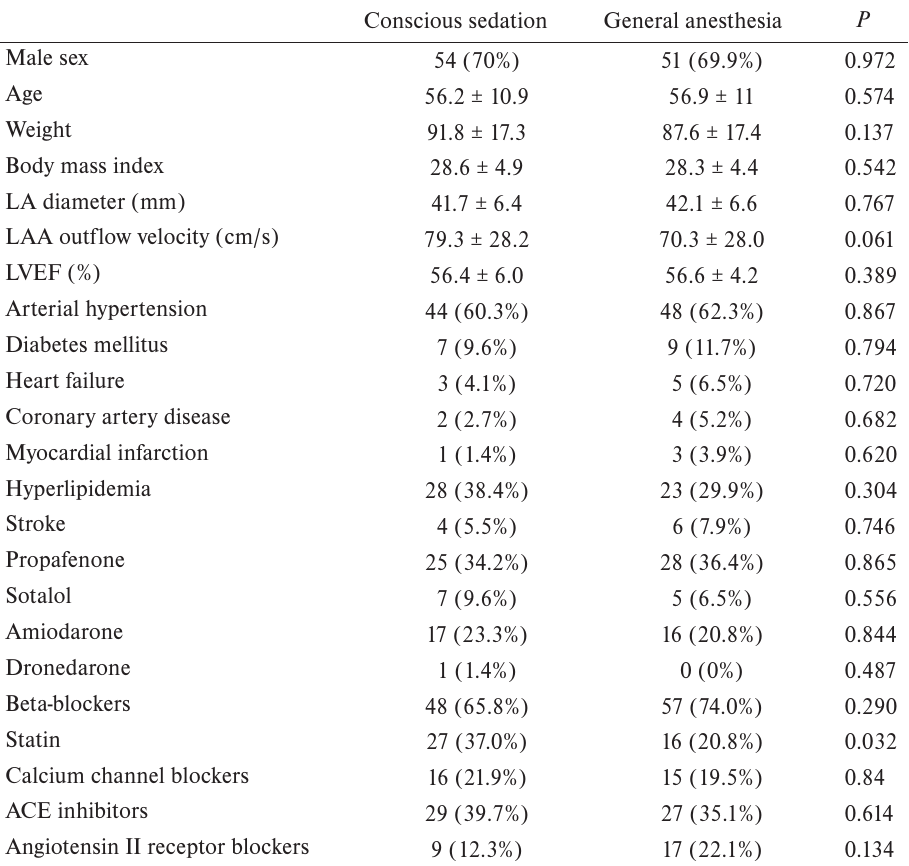
Table 1. Baseline clinical and echocardiographic characteristics of the patient group. Conscious sedation